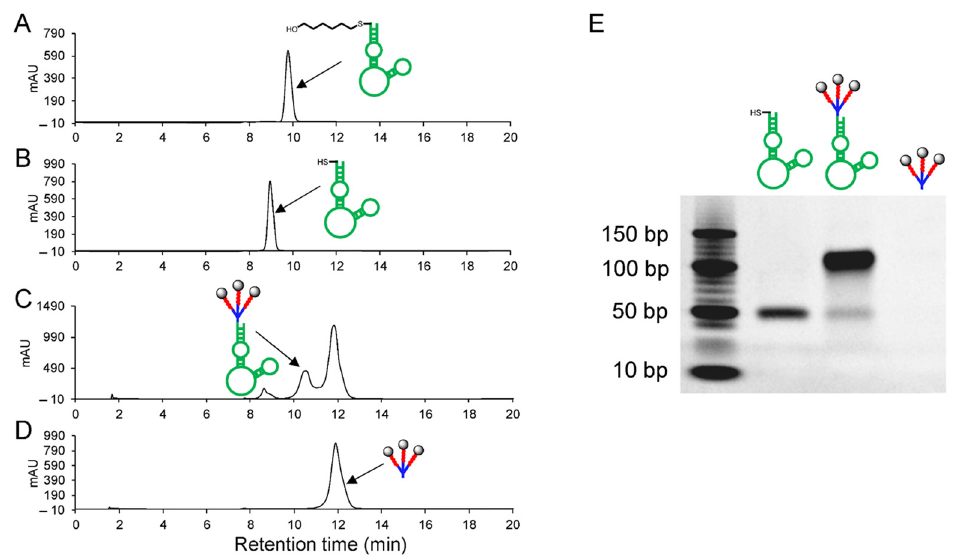
Figure 3. Preparation and characterization of Apt–cL–triGemcitabine. ( A ) HPLC chromatogram of